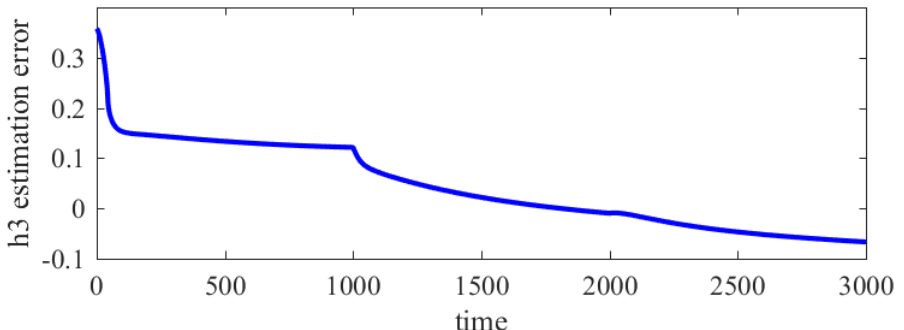
Figure 11. Correlation oefficient based h 3 estimation error (noise